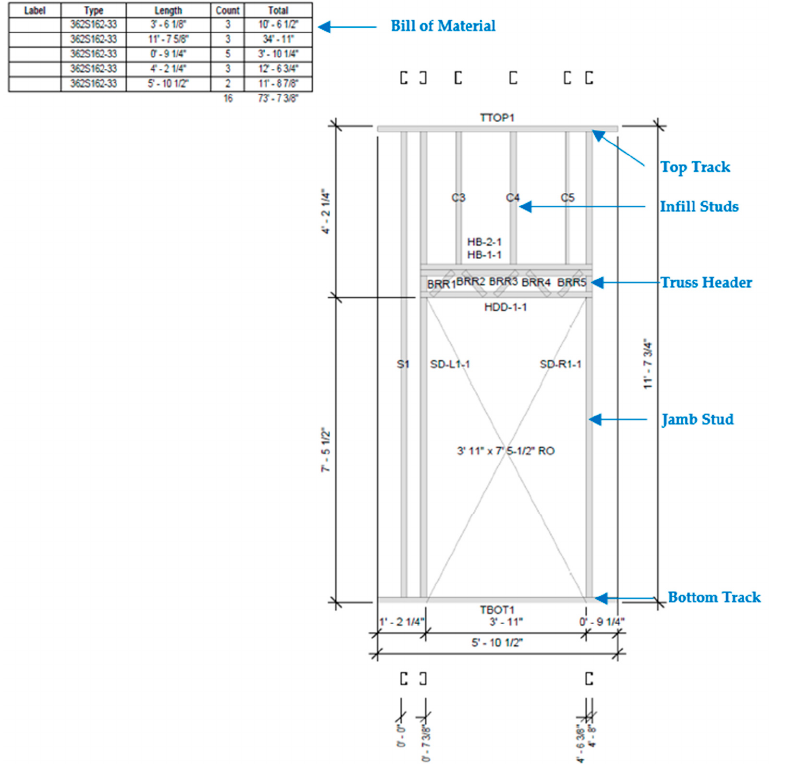
Figure 4. Example panel shop fabrication ticket. Buildings 2023 , 13 , x FOR PEER REVIEW